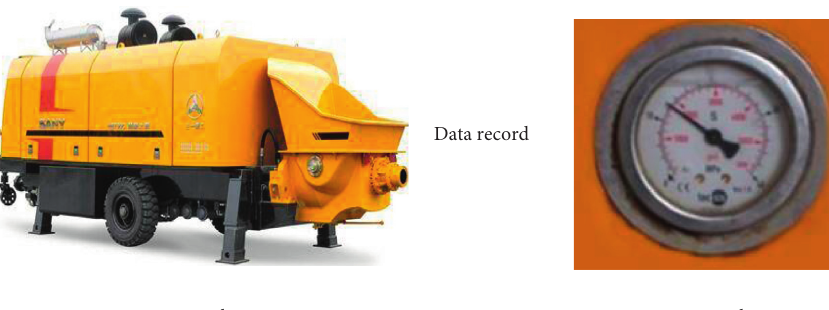
Figure 9: Pressure record via huge pump on the